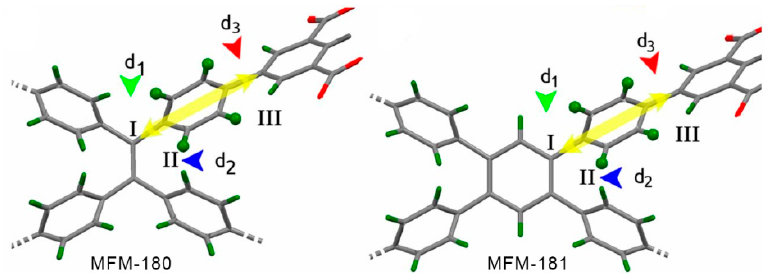
Figure 7. Rotator environment in MFM-180 and MFM-181. The colored arrows mark the closest steric interactions. Reproduced from [9].